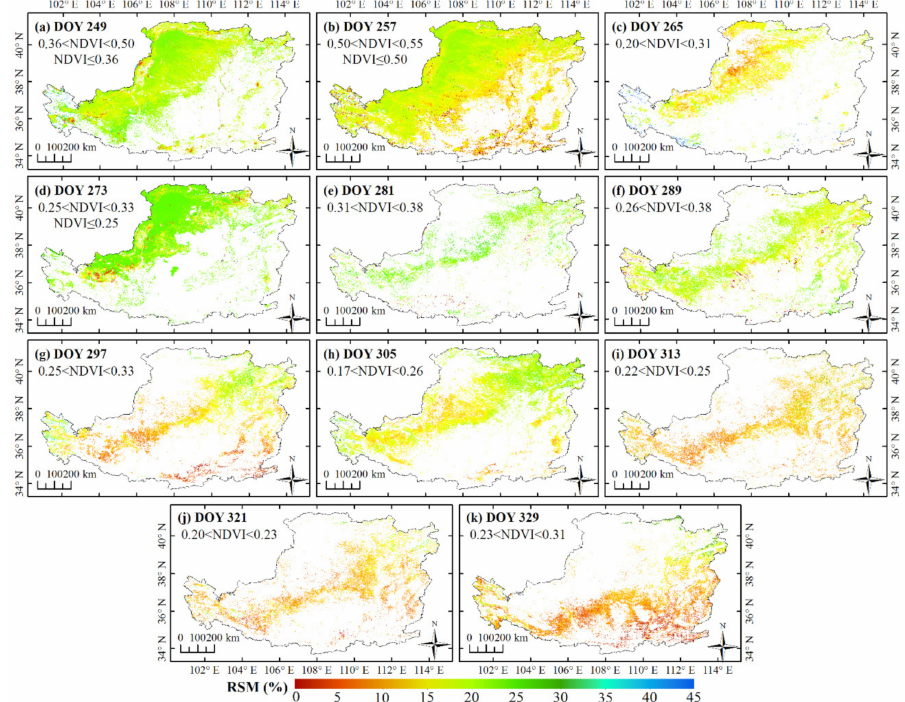
Figure 13. Spatiotemporal patterns of the relative soil moisture in the autumn of 2017. ( a ) DOY 249 for 0.36 < NDVI < 0.50 and NDVI ≤ 0.36 using the ATI / TVDI joint model and ATI-based model, respectively, ( b ) DOY 257 for 0.50 < NDVI < 0.55 and NDVI ≤ 0.5 using ATI / TVDI joint model and ATI-based model, respectively, ( c ) DOY 265 for 0.20 < NDVI < 0.31 using the ATI / TVDI joint model, ( d ) DOY 273 for 0.25 < NDVI < 0.33 and NDVI ≤ 0.25 using the ATI / TVDI joint model and ATI-based model, respectively, ( e ) DOY 281 for 0.31 < NDVI < 0.38 using the ATI / TVDI joint model, ( f ) DOY 289 for 0.26 < NDVI < 0.38 using the ATI / TVDI joint model, ( g ) DOY 297 for 0.25 < NDVI < 0.33 using the ATI / TVDI joint model, ( h ) DOY 305 for 0.17 < NDVI < 0.26 using the ATI / TVDI joint model, ( i ) DOY 313 for 0.22 < NDVI < 0.25 using the ATI / TVDI joint model, ( j ) DOY 321 for 0.20 < NDVI < 0.23 using the ATI / TVDI joint model, ( k ) DOY 329 for 0.23 < NDVI < 0.31 using the ATI / TVDI joint